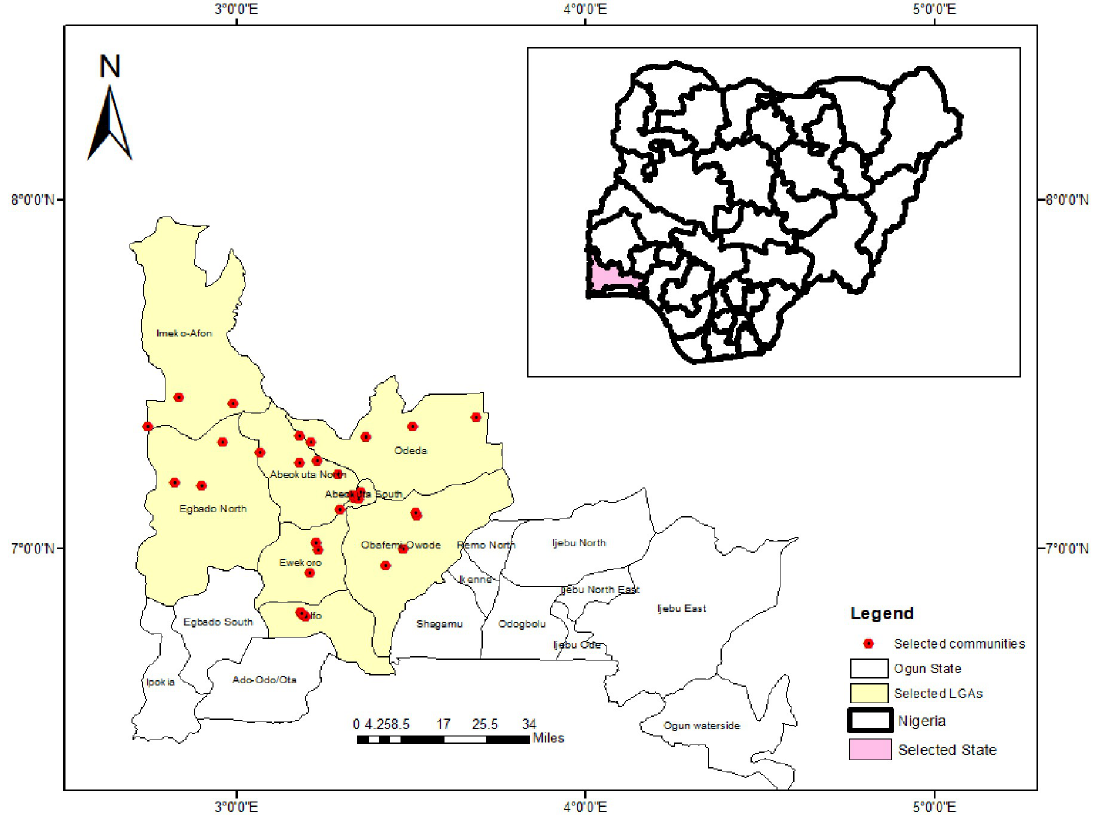
Fig 1. Map showing the study locations and LGAs in Ogun State. This figure was created by the authors in R programming software (R version 4.1.2, Vienna, Austria). Available at https://www.R-project.org/. The Nigerian shapefile was obtained from World BankDataCatalog (https://data.humdata.org/dataset/geoboundaries-admin-boundaries-for-nigeria) an Open license standardized resource of boundaries (i.e., state, county) for every country in the world.